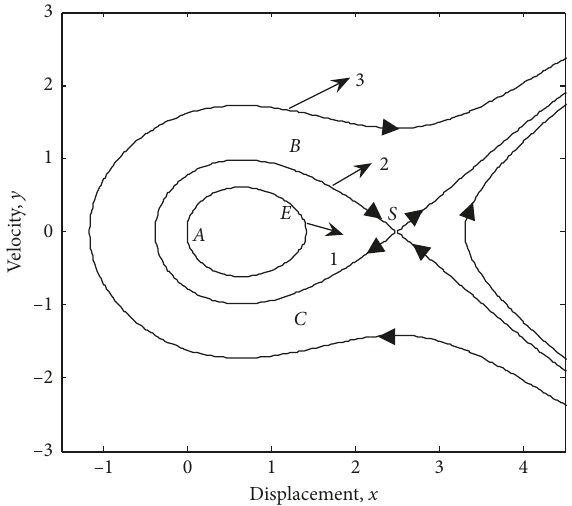
Figure 2: Phase trajectories for the unperturbed system